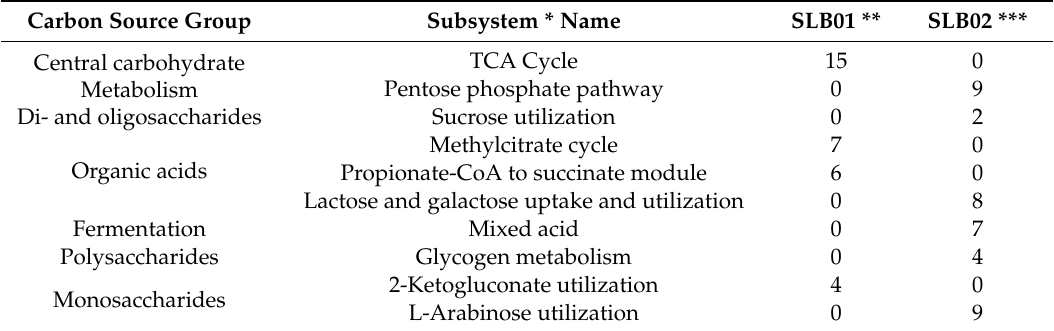
Table 3. Carbon sources and metabolism subsystem di ff erences in the Janthinobacterium sp. SLB01 and Flavobacterium sp. SLB02